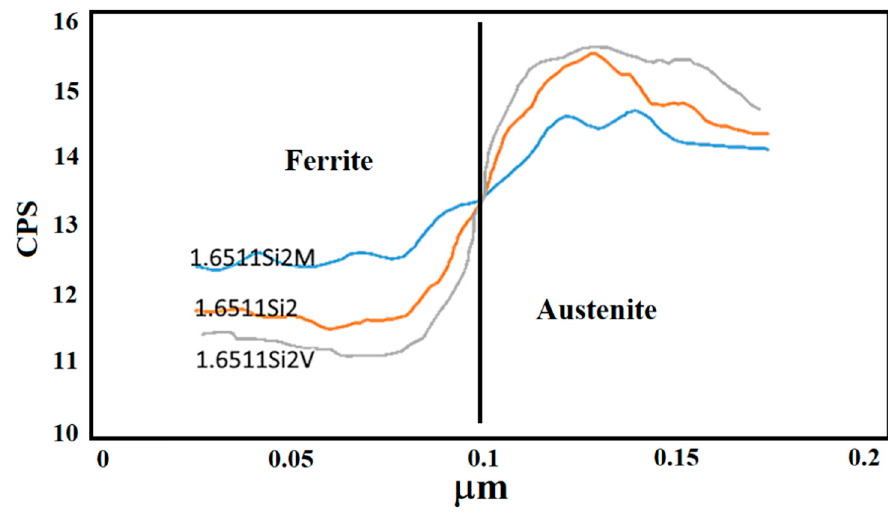
Figure 9. Linear EDS graph of the carbon content in 1.6511Si2, 1.6511Si2V, and 1.6511Si2M.